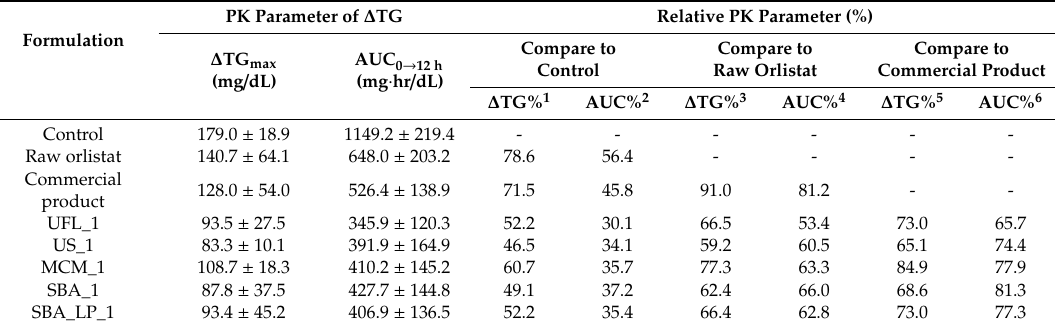
Figure 9. ( a ) ∆ TG vs. time profiles and ( b ) AUC 0 → 12 of ∆ TG in SD-rats, after oral administration 1 mL olive oil, followed by administration of raw orlistat, the commercial product, and SCMA processed orlistat formulations (n = 6). *: p < 0.05, vs. control; + : p < 0.05, vs. raw orlistat; # : p < 0.05, vs. commercial product. Table 2. Pharmacokinetic (PK) parameters of ∆ TG in SD-rats, after oral administration 1 mL olive oil, followed by administration of raw orlistat, the commercial product, and SCMA processed orlistat formulations (n = 6).